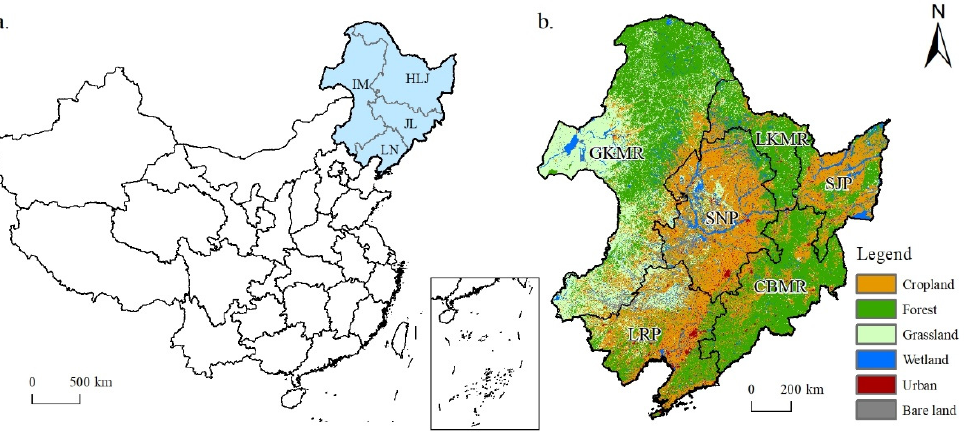
Figure 1. Location of the study area ( a ) and the geographic sub-regions map with land use/cover details of Northeast China in 2020 ( b ).